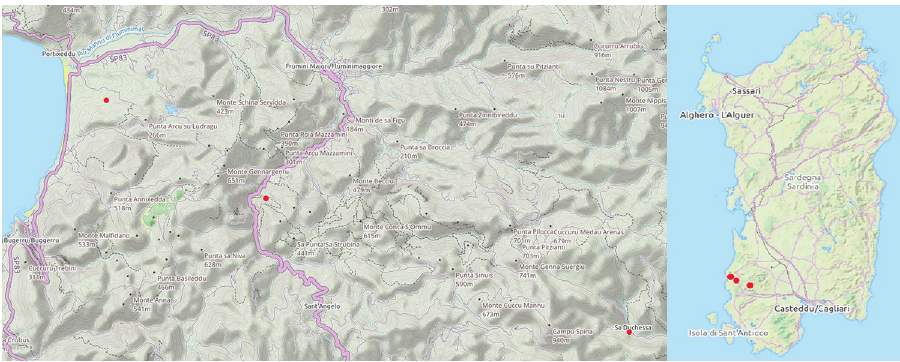
Figure 2. Geographic range and distribution map of Ophrys normanii